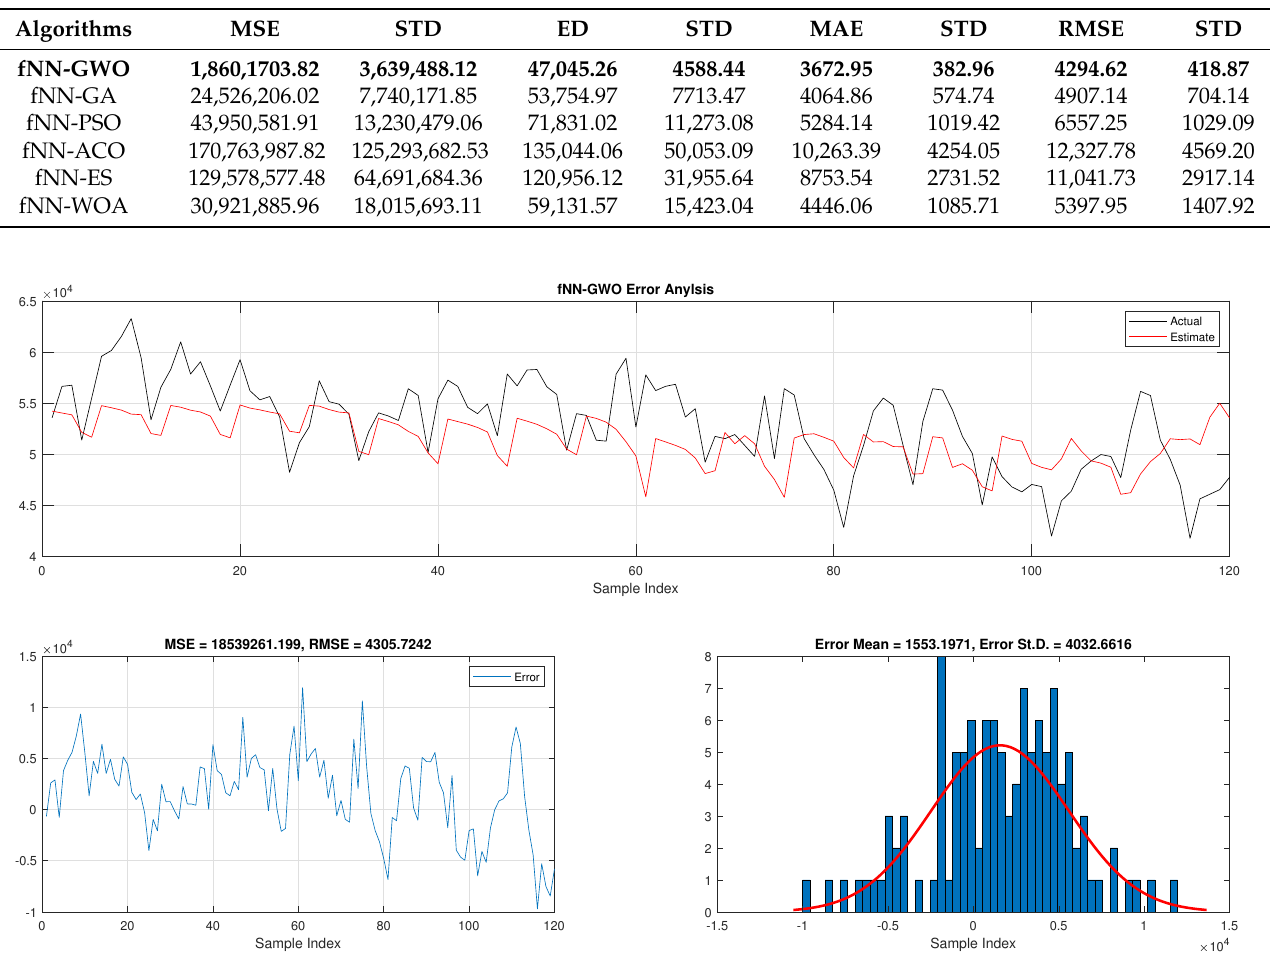
Figure 15. Error analysis of the total daily load consumption with fNN-GWO best